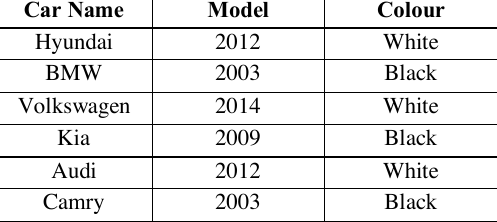
Table 1. Distributed exhibition cars